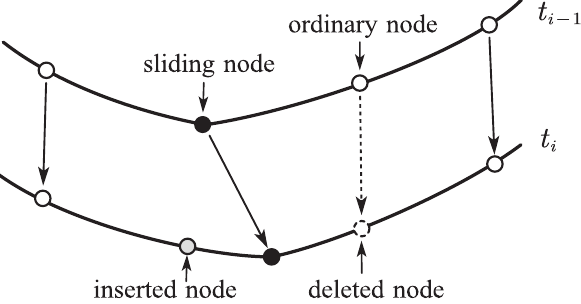
Figure 7. Illustration of element length-control scheme in sliding joint